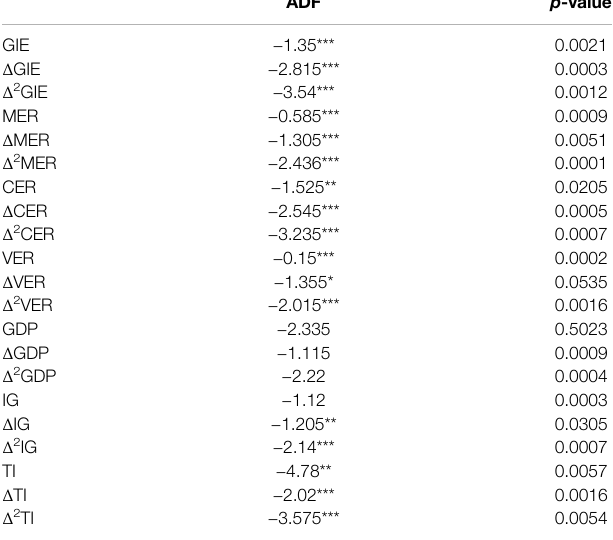
TABLE 4 | Unit root test result.